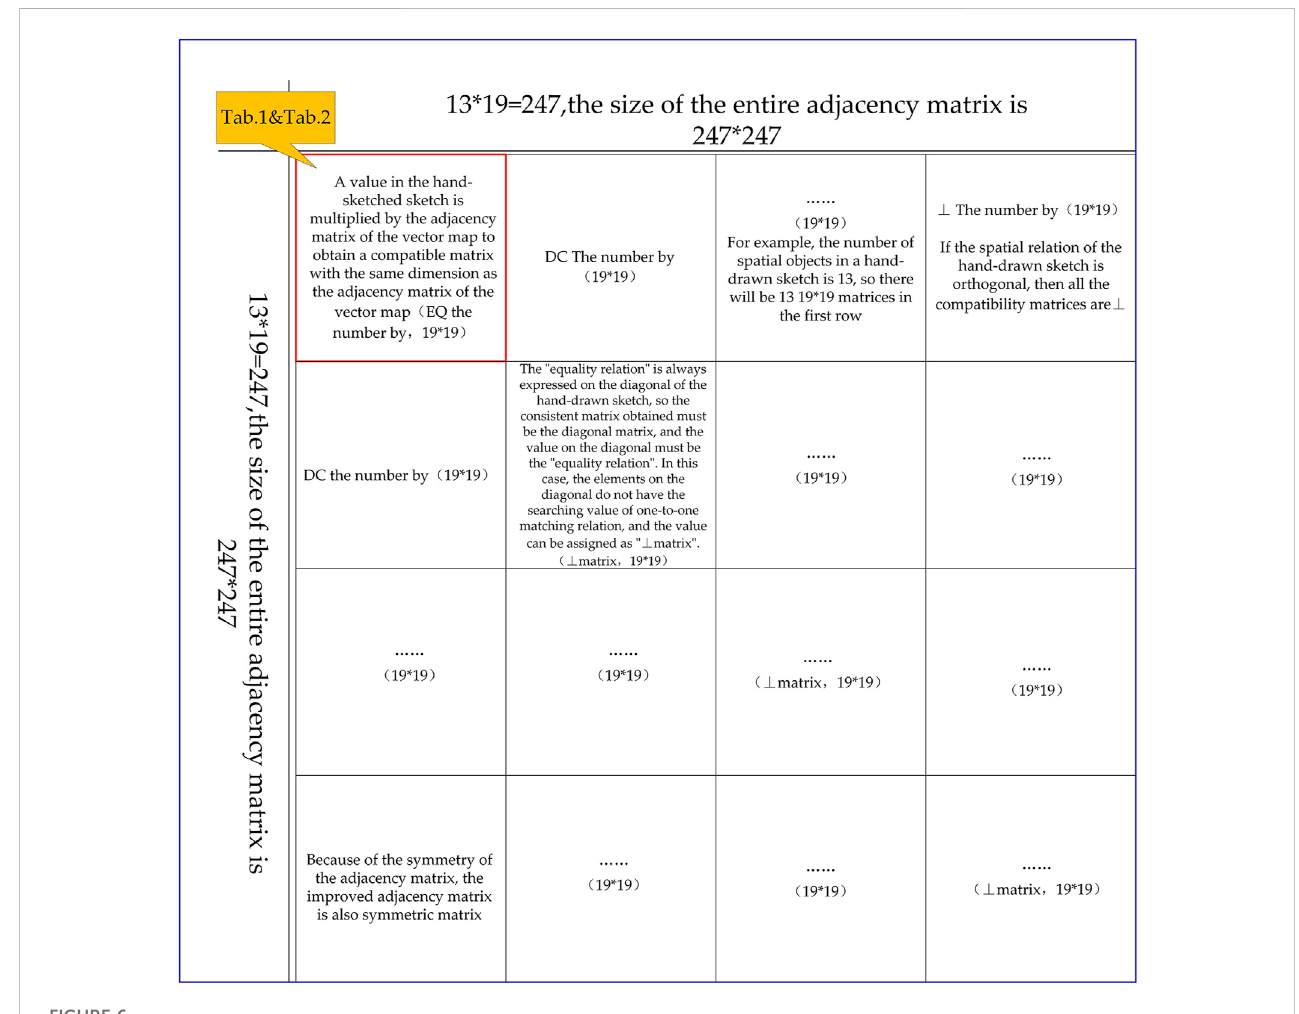
FIGURE 6 Characteristics and construction rules of the improved adjacency